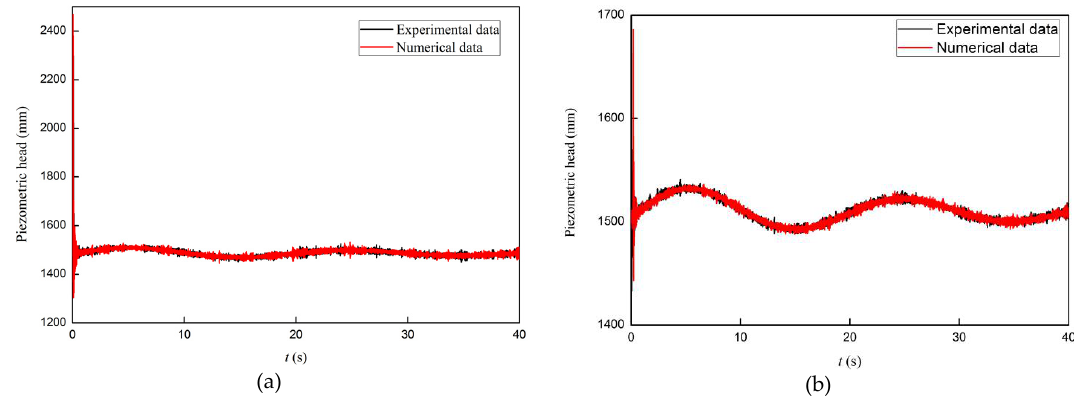
Figure 5. Pressure fluctuation history with fluid – structure interaction (FSI) taking into account ( a ) closer outlet; ( b ) near surge chamber. The red solid line refers to numerical result, the black solid line refers to experimental result.